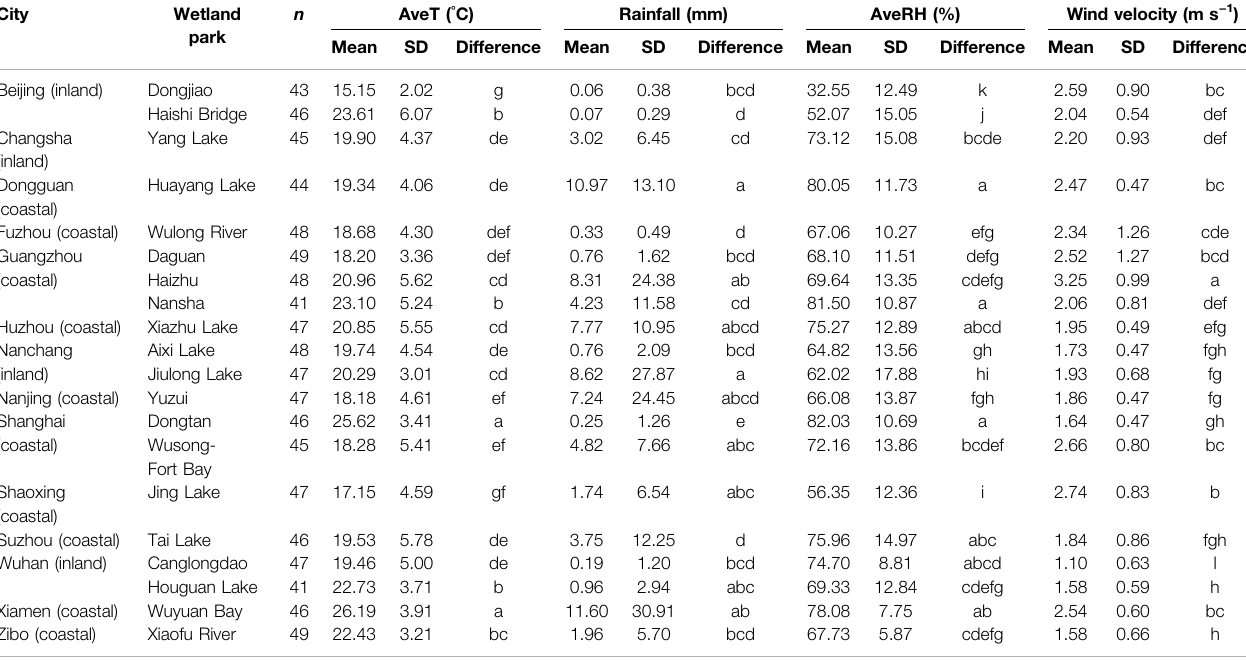
TABLE 1 | Difference of climatic factor records for visitors taking photographs in different wetland parks from cities along the eastern coast of mainland China.